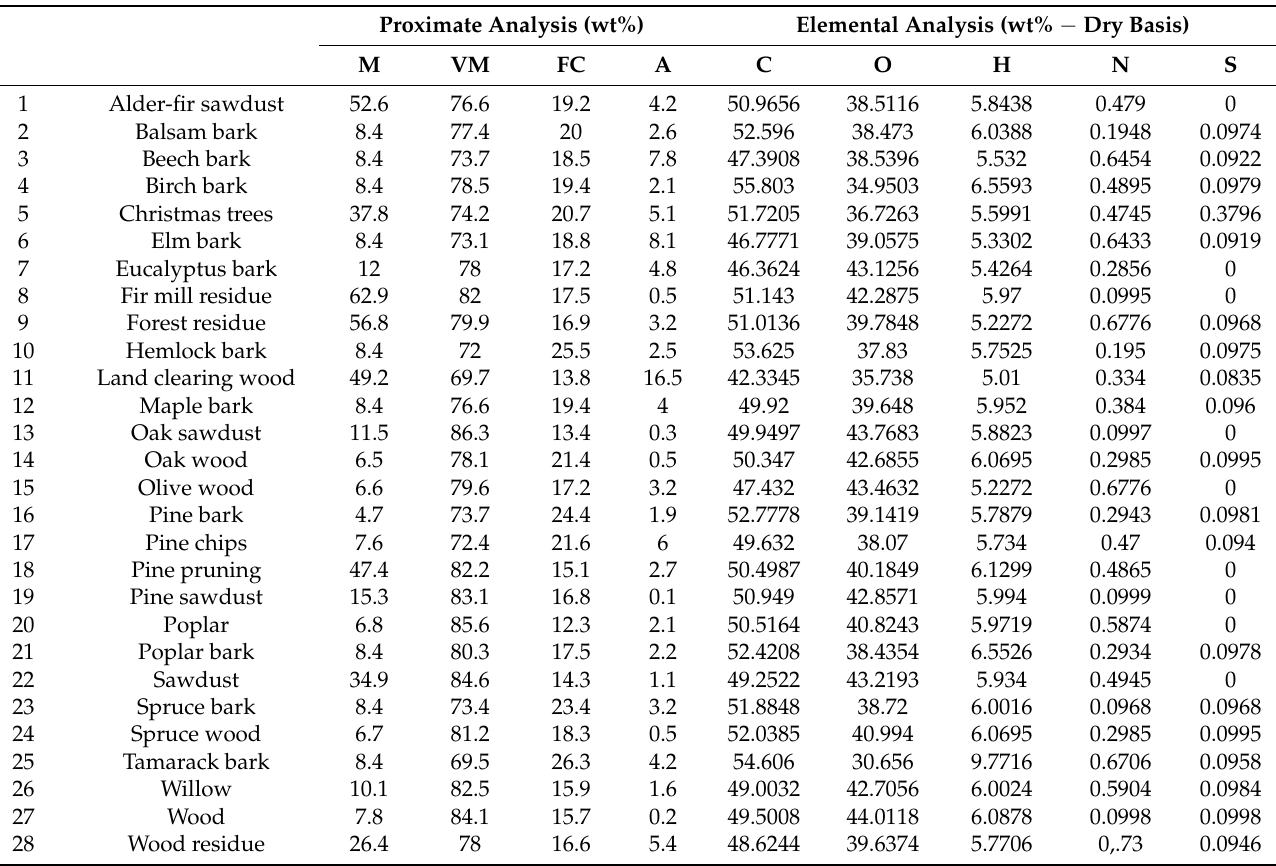
Table 2. Ultimate and proximate analysis of 28 WB&FR [44–61], (M: moisture content, VM: volatile materials, FC: fixed carbon, A: ash, C: carbon, O: oxygen, H: hydrogen, N: nitrogen and S: